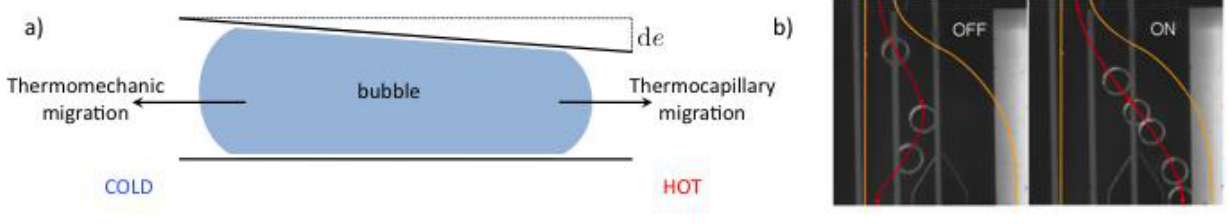
Figure 21. ( a ) Sketch of the competition between thermocapillary and thermomechanical effects on bubble migration. Reprinted with permission from [28]; Copyright 2011, American Institute of Physics. ( b ) Images of a 300 µm diameter bubbles inside a switching device: ( left ) without actuation, and ( right ) with a 4 °C/mm temperature gradient. Reprinted with permission from [30]. Copyright 2010, Royal Society of